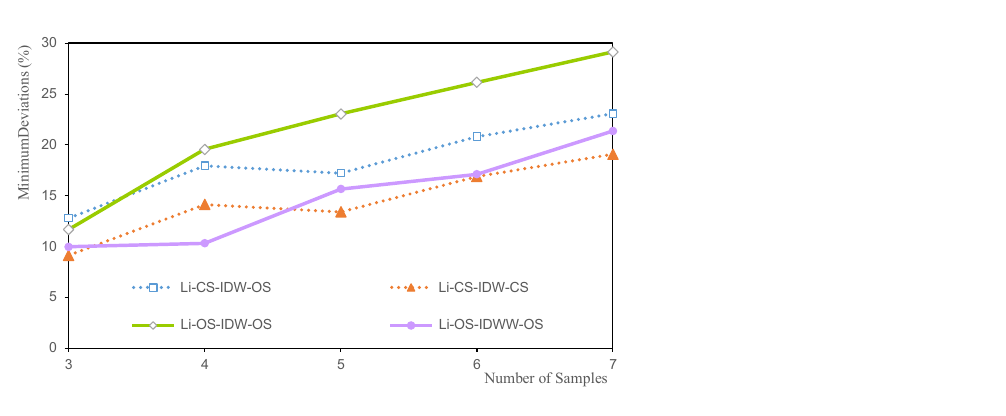
Figure 9. Deviation of the Li minimum